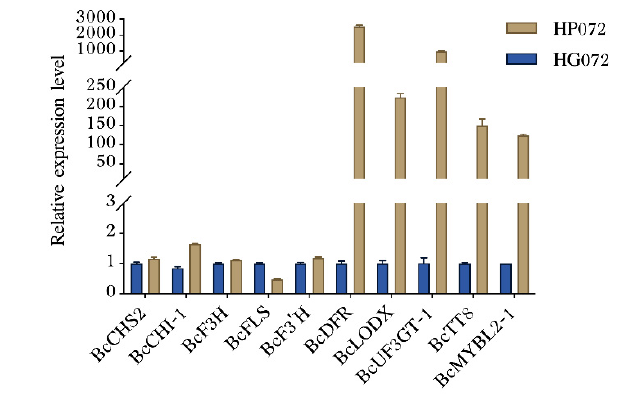
Figure 4. Analysis of genes related to anthocyanin biosynthesis-related genes using the RT-qPCR. Gene expression levels were normalized to BcActin . Error bars represent the standard error of the mean ( n = 3). Table 4. Gene list verified by RT-qPCR.